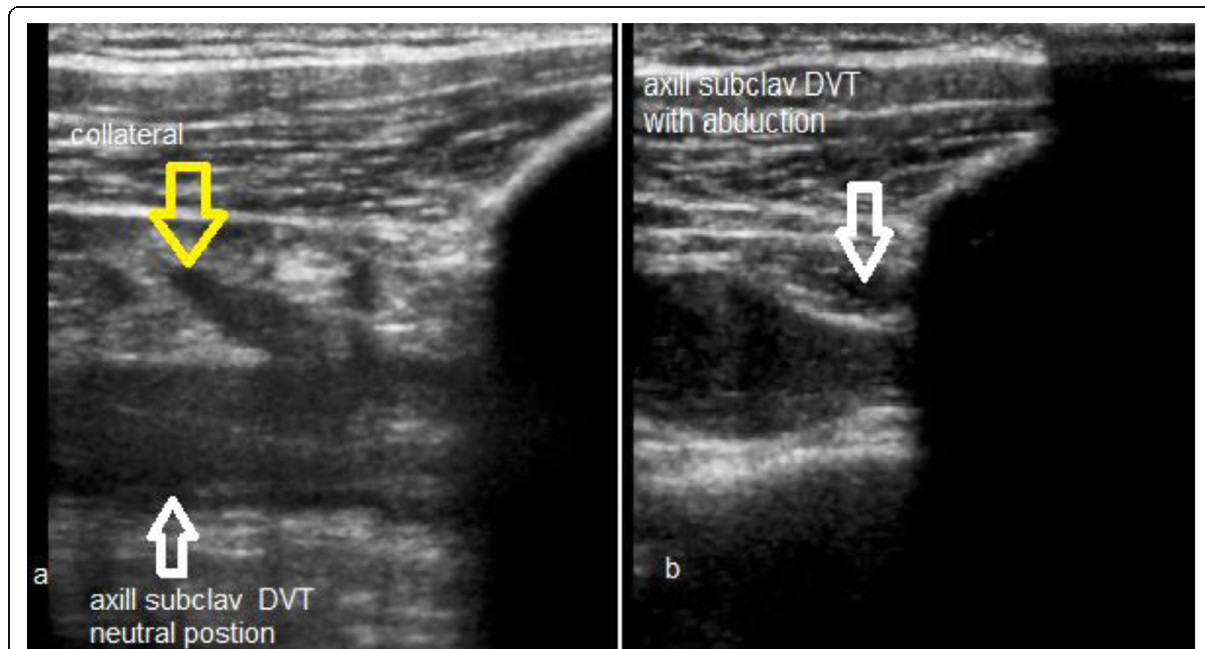
Fig. 8 a B-mode image of the axillary-subclavian vein junction showing thrombus filled vein segment (ASVT) (open white arrow) with venous collaterals arising at this level (yellow open arrow) in the neutral position. b B-mode image with arm abduction, a peaking of the vein segment with marked compression of the thrombus filled vein at the costo-clavicular space were seen (open white